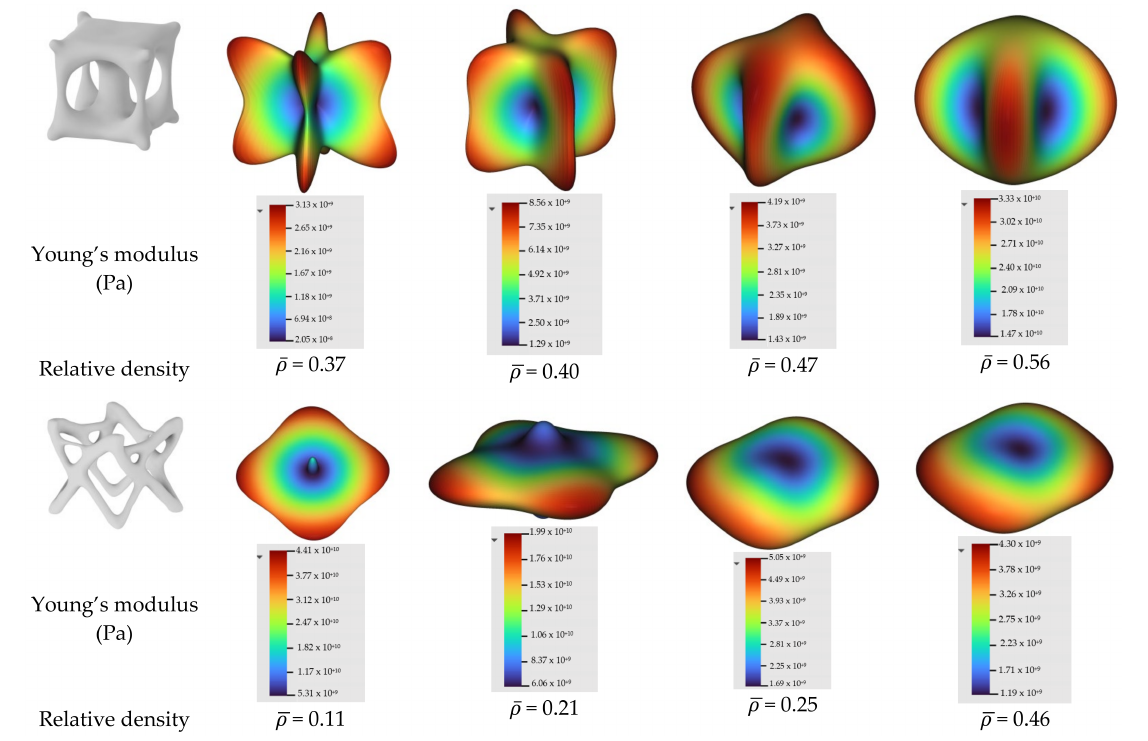
Figure 16. The elastic moduli of both homogenized lattices in different relative densities ( ρ ).